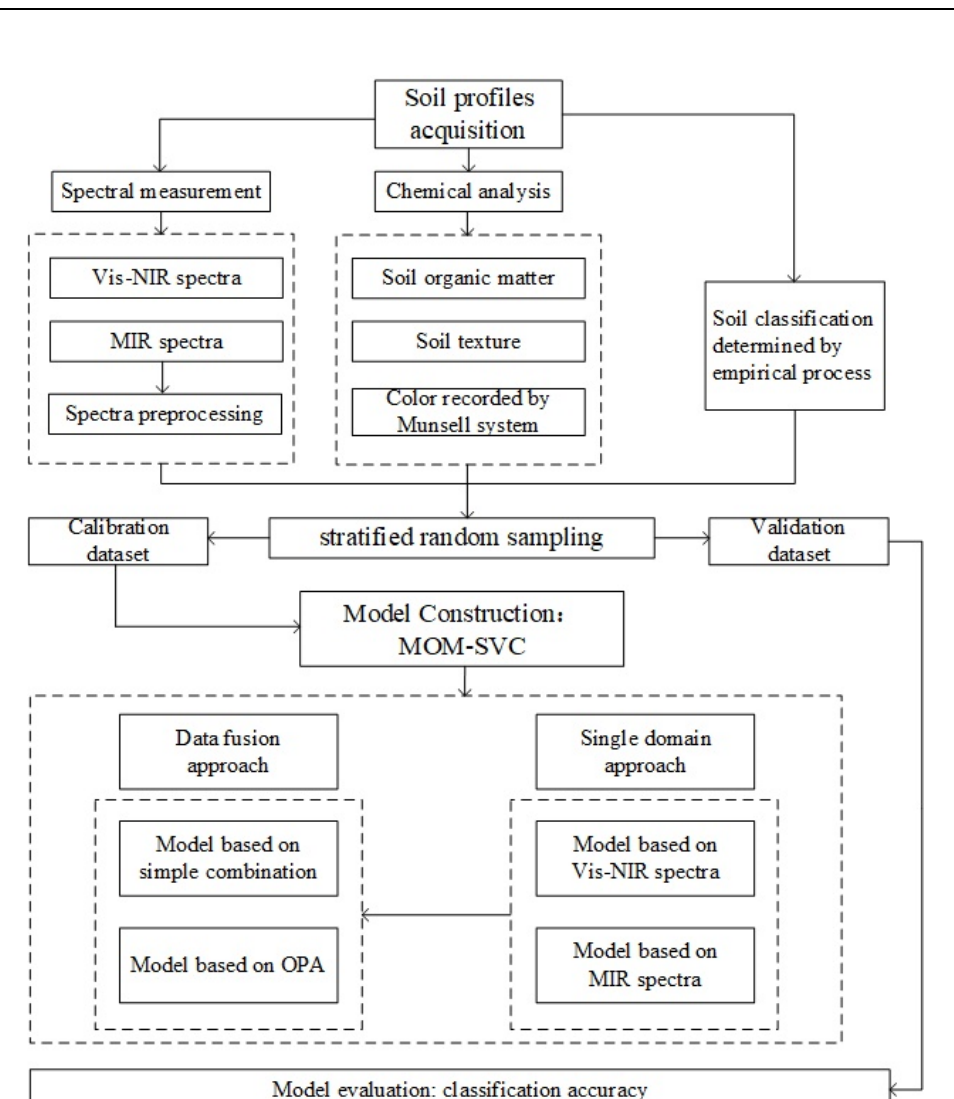
Figure 3. Workflow in this study.